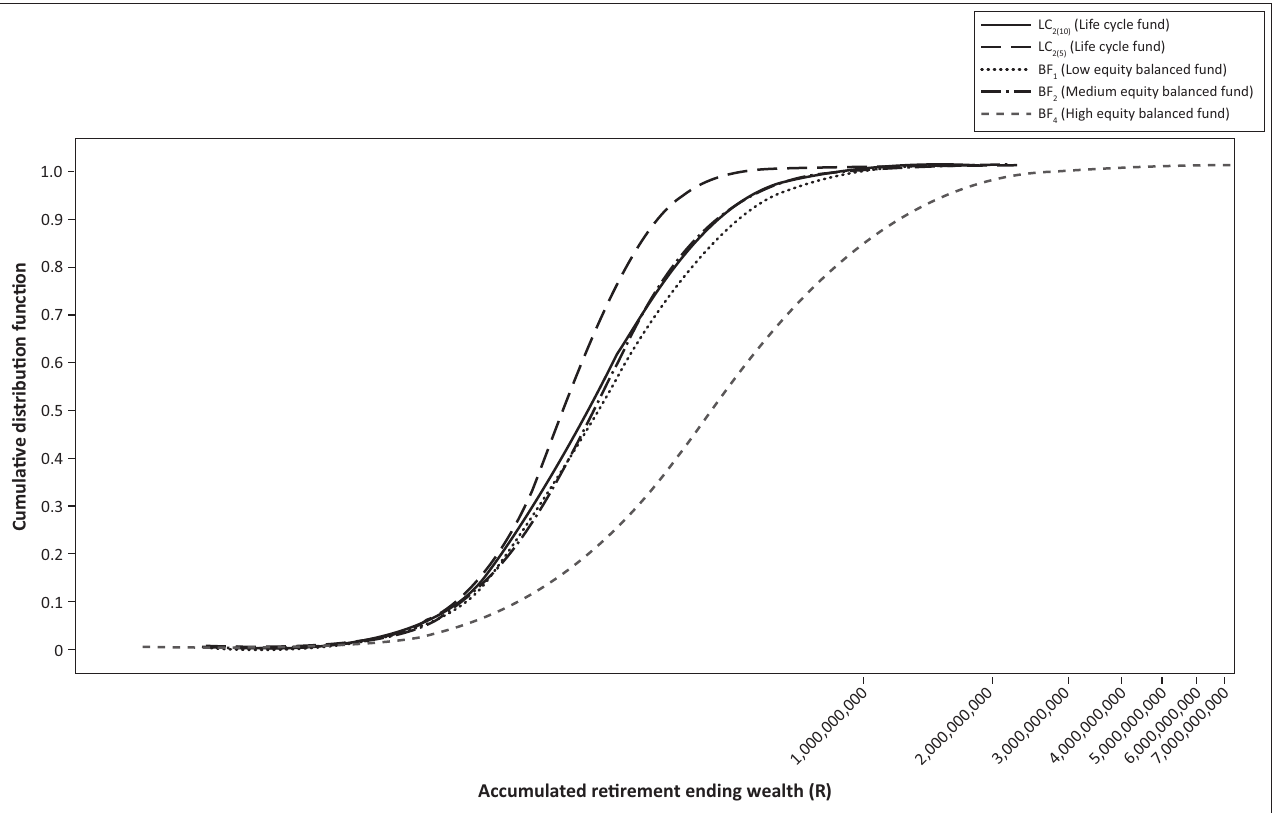
FIGURE 4: Cumulative distribution functions of accumulated retirement ending wealth for models LC TABLE 4: ASD results of life cycle funds against balanced funds – dissimilar starting asset allocation. Model Balanced fund